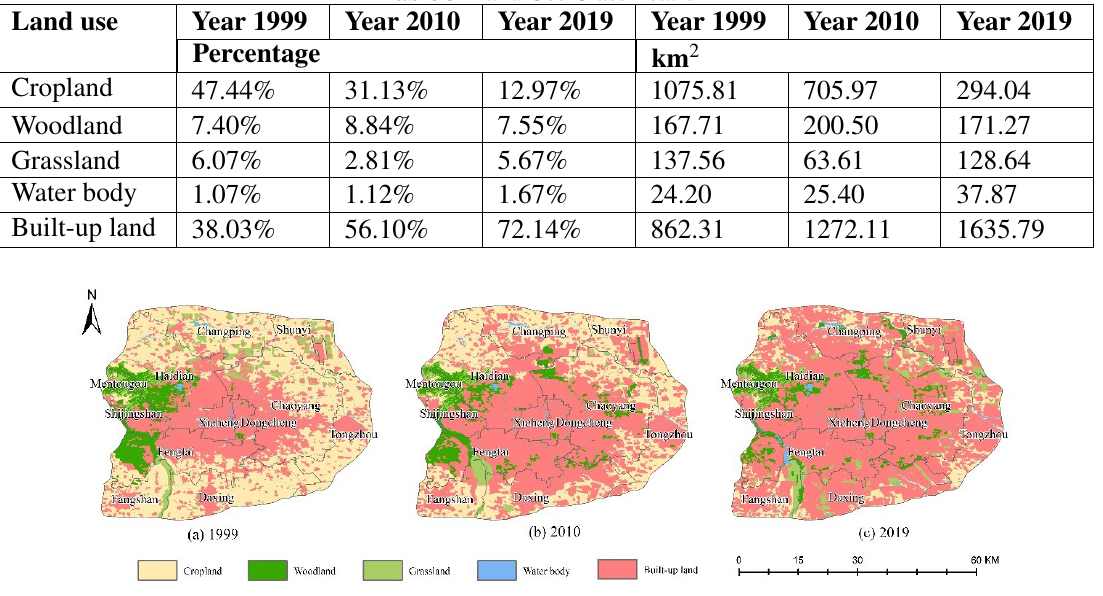
Fig. 3 LUCC in Beijing from 1999 to 2019. LUCC, land use cover change.